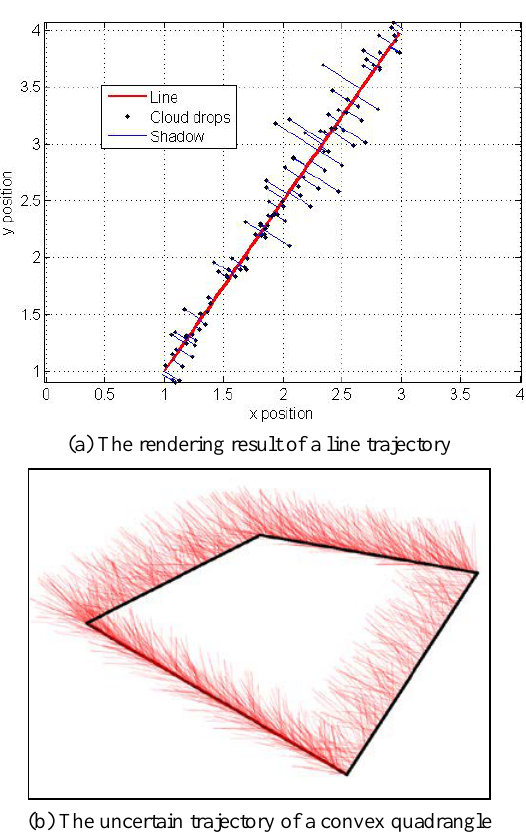
Figure 4. The uncertain trajectory based on uncertain